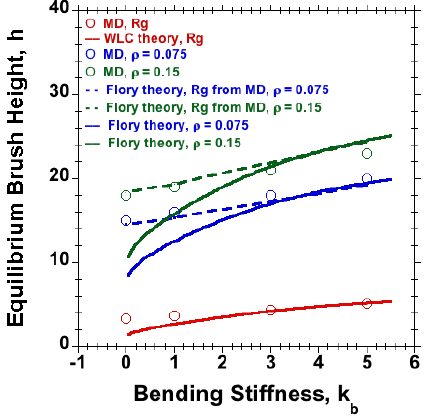
Figure 4. Radius of gyration R g of the free chain (red circles) and equilibrium-brush height versus chain bending stiffness ( k b ) at two different grafting densities, ρ = 0.075 (blue circles) and ρ = 0.15 (green circles), obtained via MD for M = 20 and N = 30 under good-solvent conditions. For comparison, we show R g for the worm-like chain (WLC) model (solid red line), the Flory theory prediction for the brush height, Equation (4) with τ = 1, using the radius of gyration R g according to the WLC model (solid blue and green lines for two different surface densities) or the R g of the free chain obtained via MD (dashed blue and green) as the undisturbed size R 0 . While the Flory predictions are in excellent agreement with our MD data when the calculated equilibrium size of the polymer is used, the WLC naturally fails to capture the effect of excluded volume on the size and brush height in the limit of flexible chains ( k b =